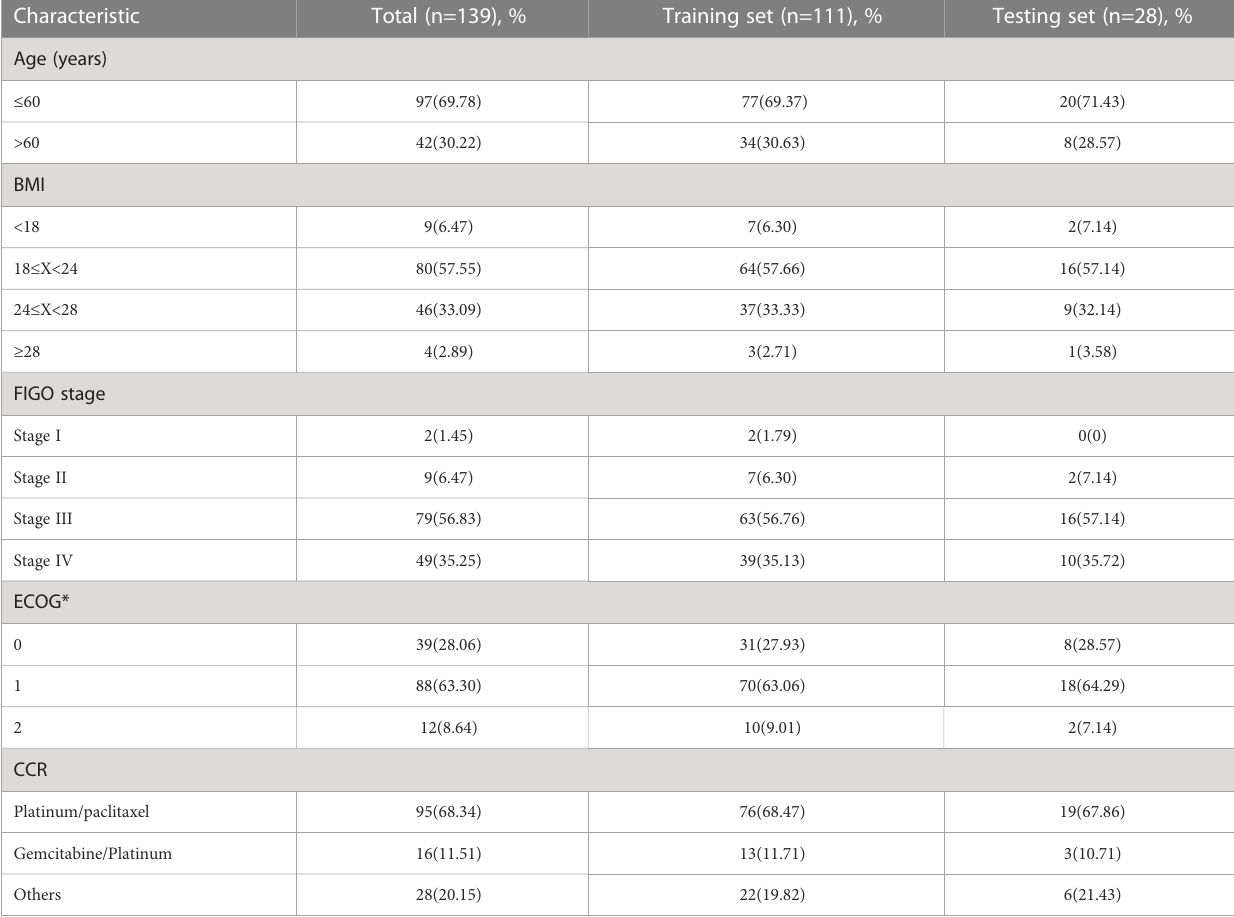
TABLE 1 Patient and Tumor